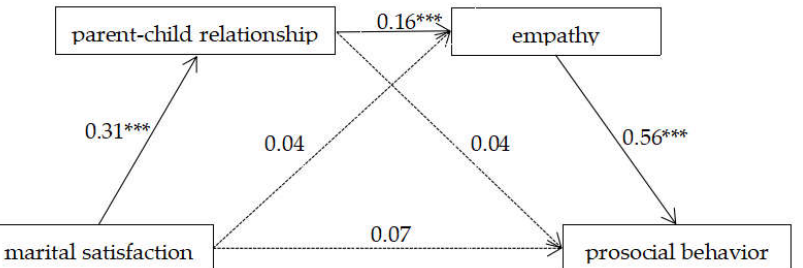
Figure 2. All the path coefficients were standardized; child age and parent education level were controlled for but are not presented in the figure for simplicity; *** p <